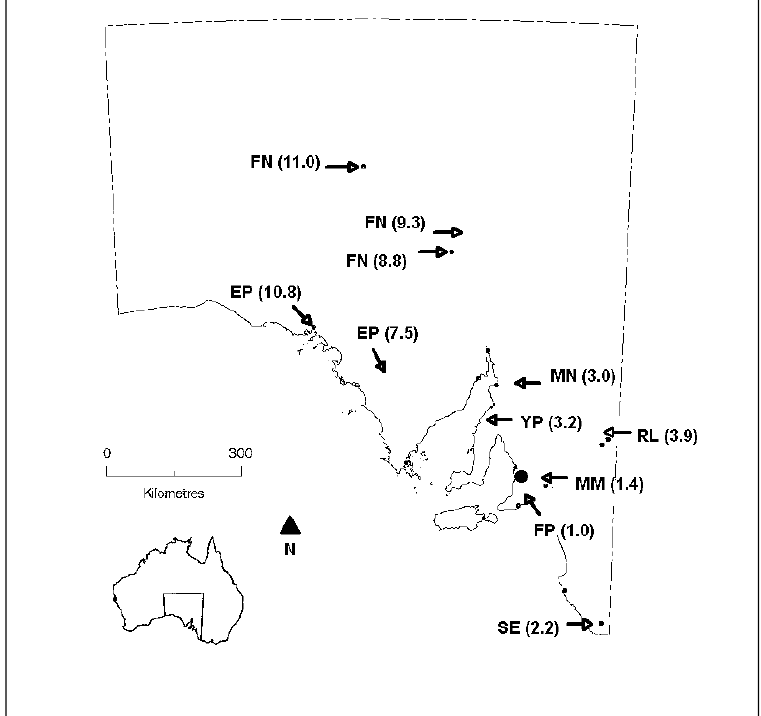
Figure 1. Map of South Australia showing the locations for study participants. Locations are abbreviated to FN (Far North); EP (Eyre Peninsula); MN (Mid-North); YP (Yorke Peninsula); RL (Riverland); MM (Mid-Murray); FP (Fleurieu Peninsula); and SE (South East). ARIA scores for each location are shown, ranging from inner regional (1.0) to very remote (11.0). The State capital (Adelaide) is represented by the large filled